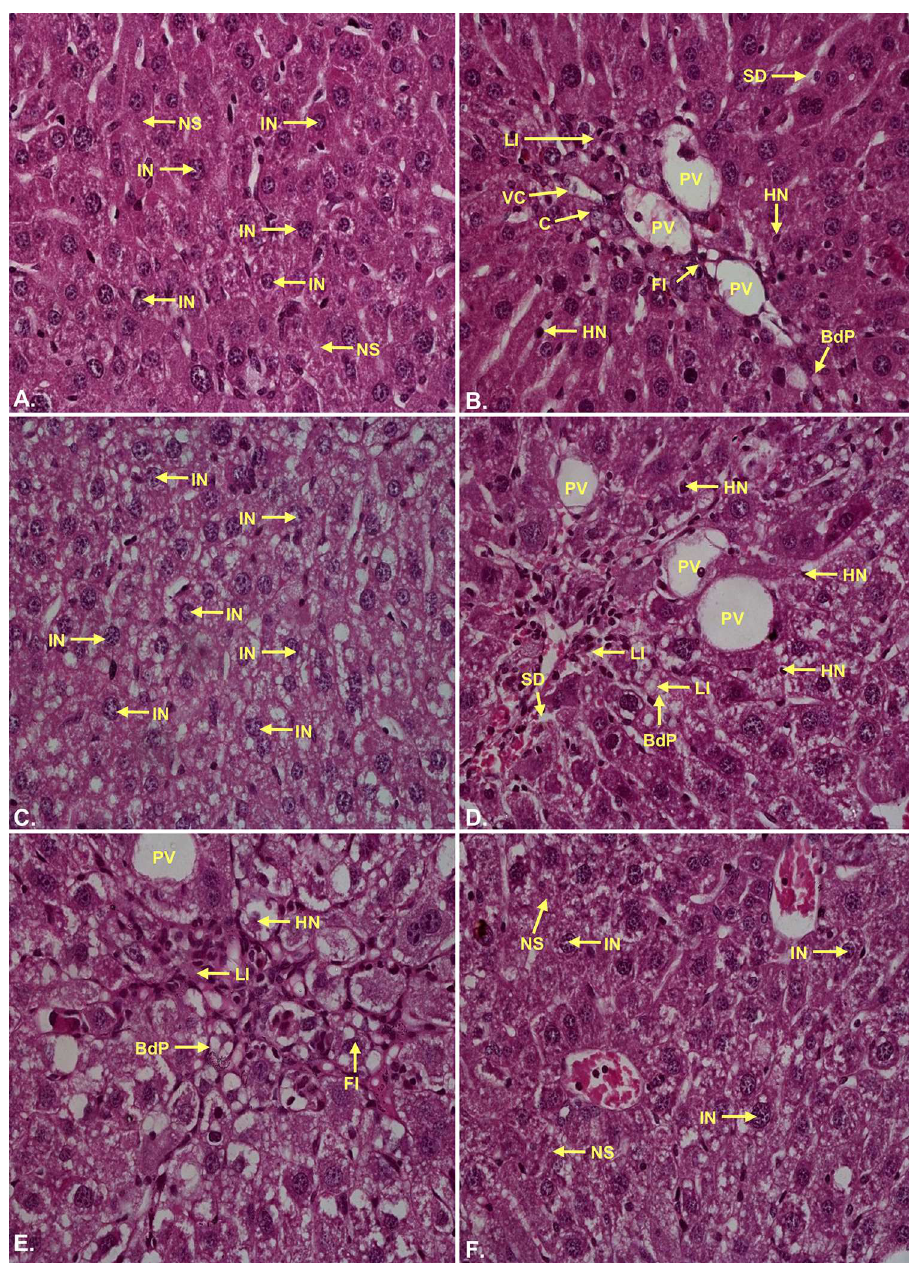
Fig 11. Photomicrographs (400×) of the histopathological examinations of the liver samples of different groups. (A) Control group liver sampled possessed well packed hepatocytes with intact nucleus (IN) and normal sinusoids (NS); (B) CCl 4 group liver possessed extensive fatty infiltrations (FI), Necrotic hepatocytes (N), prominent signs of inflammation with leukocyte infiltrations (LI), prominent calcification (C) around the congested vesicles (VC) with bile duct proliferations (BdP); (C) Silymarin group liver samples were characterized with normal sinusoids (NS) and intact nucleus (IN) containing healthy hepatocytes; (D) CBLL group demonstrated lower fatty infiltrations (FI), sinusoidal dilations (SD) and leukocyte infiltrations (LI); (E) CBLM group resulted in renewal of normal hepatic architecture with several hepatocytes with intact nucleus (IN) and lowered sinusoidal dilations (SD); (F) CBLH group showed near to normal hepatic architecture with predominantly intact nucleus (IN) containing normal hepatocytes and undiluted normal sinusoids (NS).